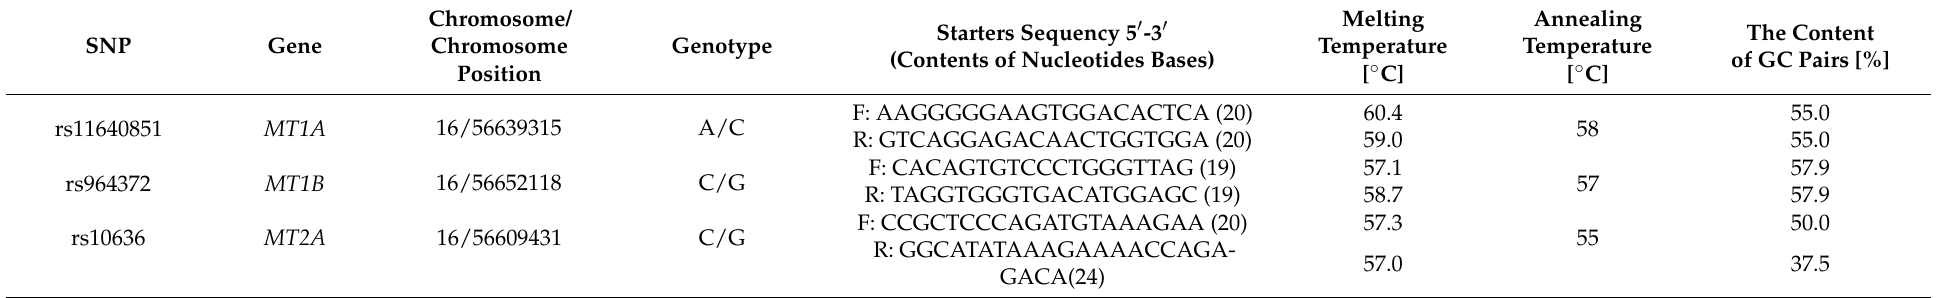
Table 10. The conditions of PCR reactions for polymorphisms in MT genes ( MT1A, MT1B, MT2A ).